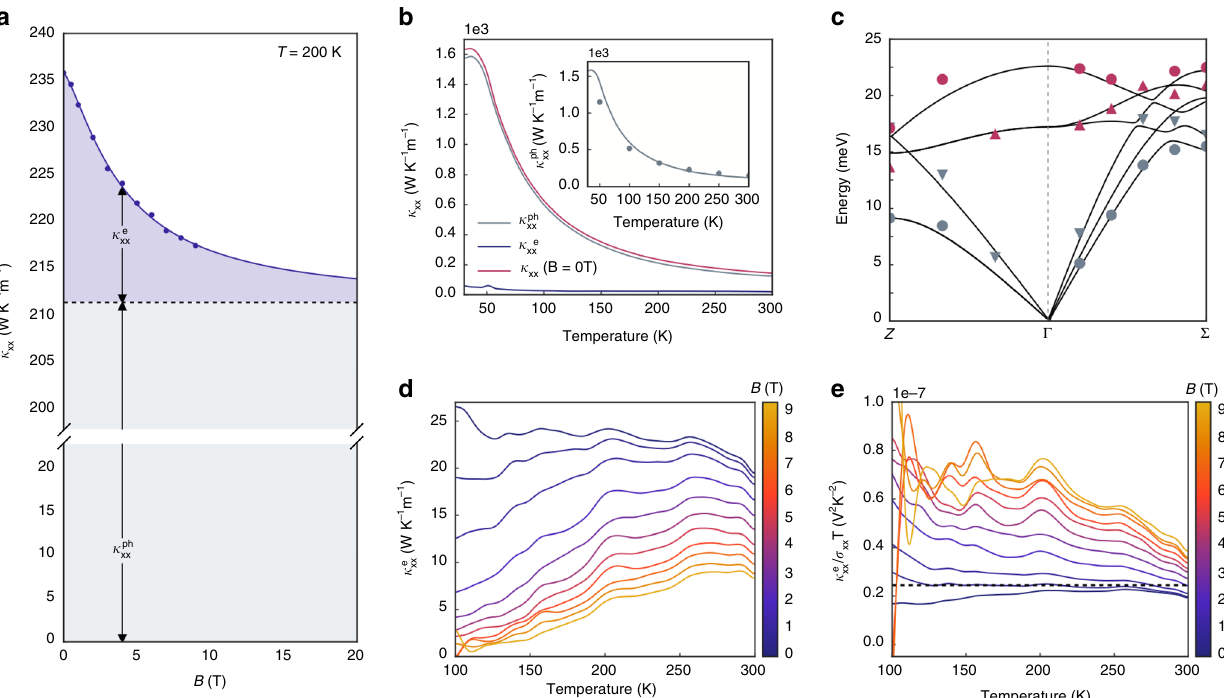
Fig. 5 The Wiedemann – Franz Law. a The schematics of the separation process of electronic thermal conductivity κ e xx from the lattice thermal conductivity using κ ph xx the fi eld dependence. b Separation of phonon and electronic contributions to the longitudinal thermal conductivity with inset displaying a computation (scattered points) of the phonon thermal conductivity from fi rst principles. c Experimentally measured values of phonon modes (scattered points) of TaP along high-symmetry line Z- Γ - Σ taken by inelastic x -ray and neutron scattering with accompanying ab initio calculation (solid lines), displaying good agreement between ab initio calculations and experiment. d The electronic contribution of the thermal conductivity as a function of temperature at various fi elds. e The Lorenz number as a function of temperature at various fi elds. The black line indicates the theoretical value of the Wiedemann – Franz